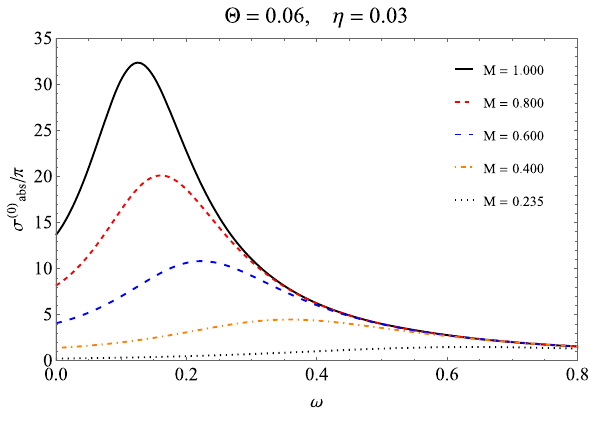
Fig. 4 Absorption cross section for small M